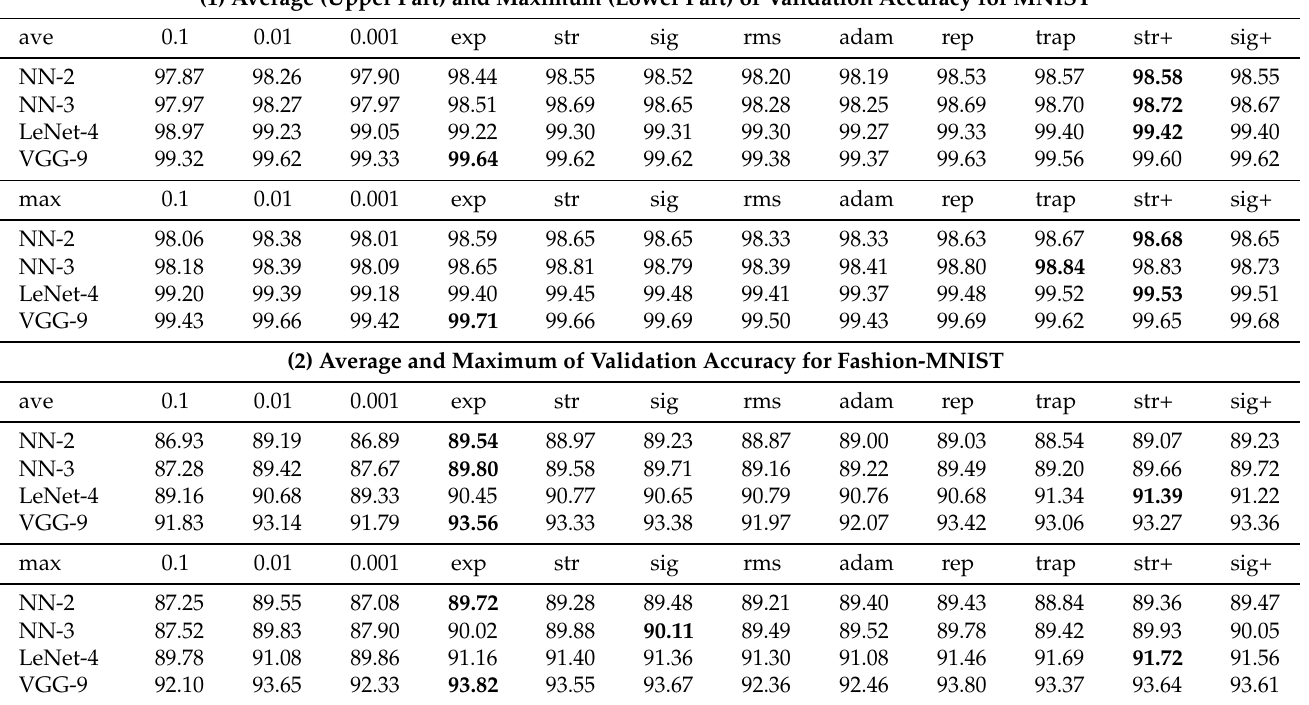
Table 2. Validation accuracy by SGD with different learning rate annealings: constant learning rate η = 0.1,0.01,0.001, exponential function (exp), staircase (str), sigmoid function (sig), RMSprop (rms), Adam (adam), twice-repeated